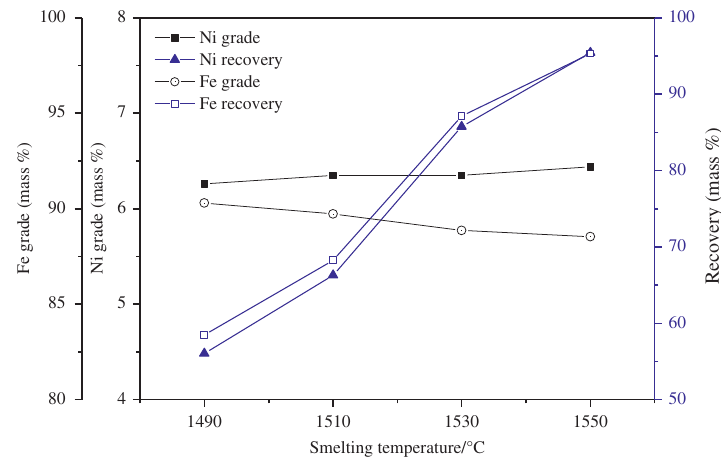
Figure 2: Effects of smelting temperature on Fe and Ni grade and recovery of ferronickel (Smelting for 10 min with 7.5% of coke ratio, binary basicity of slag as 1.0, 18% of MgO and 3% of Al 2 O 3 in slag).